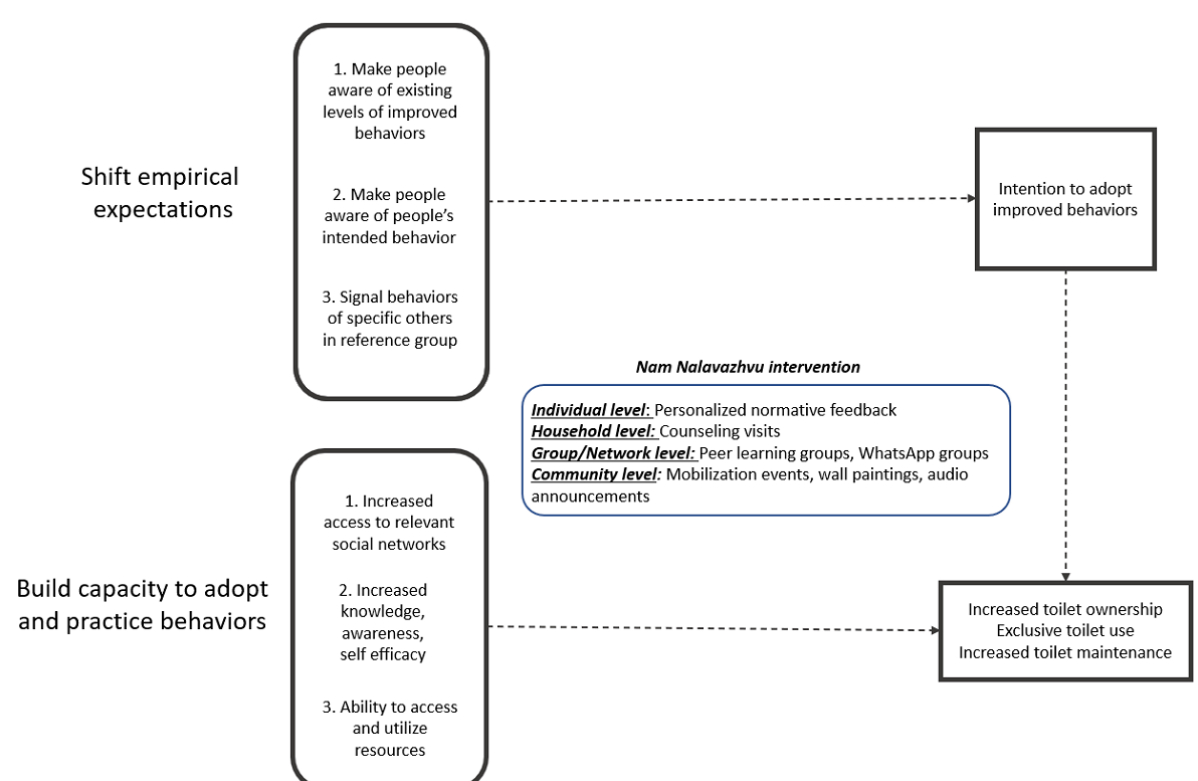
Figure 3. Theory of change for the Nam Nalavazhvu behavior change intervention, Tamil Nadu, India 2020